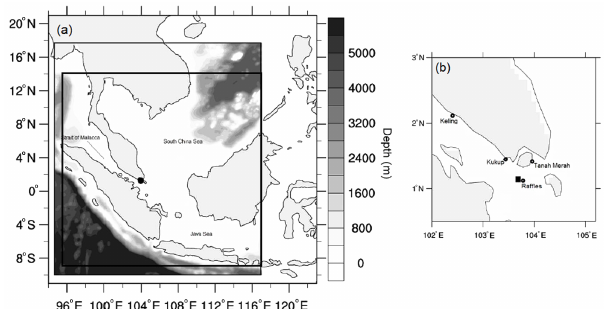
Figure 1. (a) Bathymetric map showing the location of Singa- pore (black circle) in relation to the climate model domain (out- ermost square), the surge model domain (shaded depth contours), and the wave model domain (innermost square). (b) Map of Singa- pore showing the location of tide gauge metres utilised for model validation, and showing the location of grid point “a” as referred to in the results section (black